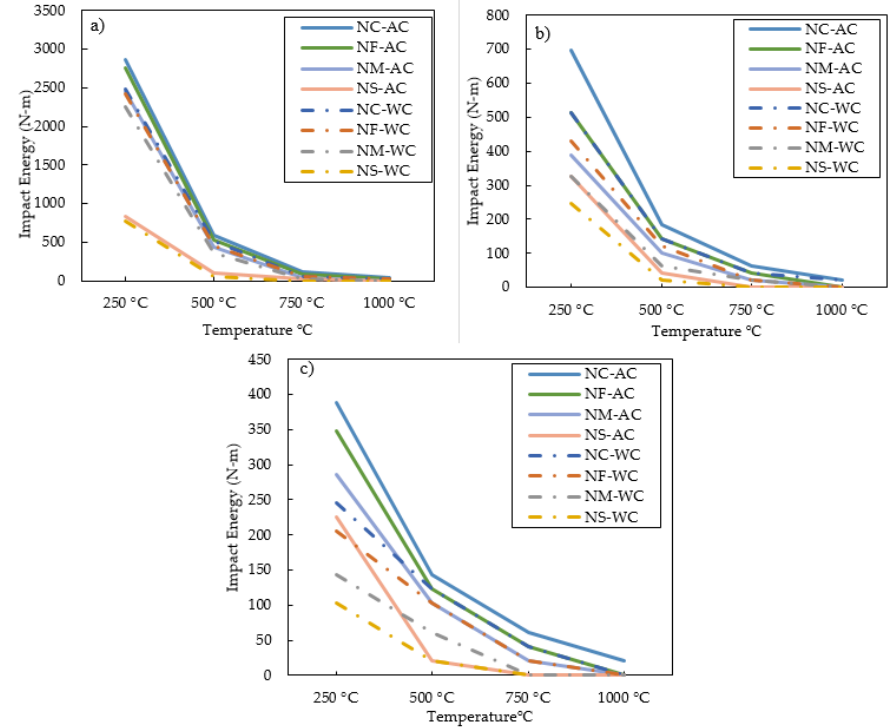
Figure 6. Impact energy versus temperature of M50 grade concrete with various percentages of nanomaterials: ( a ) 10%; ( b ) 20%; ( c ) 30%.